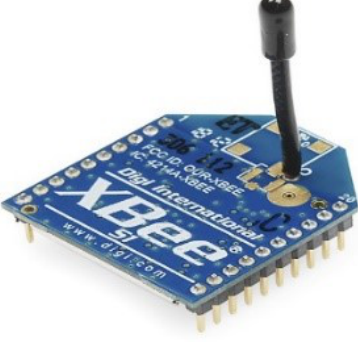
Figure 10. XBee pro